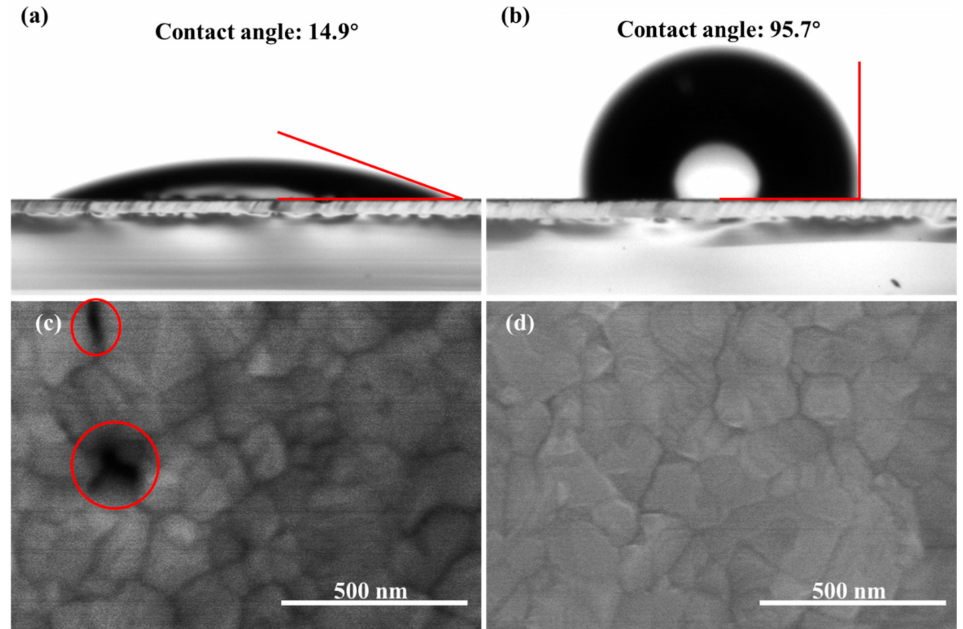
Figure 1. Contact angles of ( a ) indium tin oxide (ITO) and ( b ) ITO / 4,4 (cid:48) -Bis(4-(di-p-toyl)aminostyryl) biphenyl (TPASBP) surfaces, and corresponding top-view SEM images of the perovskite films grown on ( c ) bare and ( d ) TPASBP-covered ITO substrates; the red circles in Figure 1c indicate pinholes in perovskite